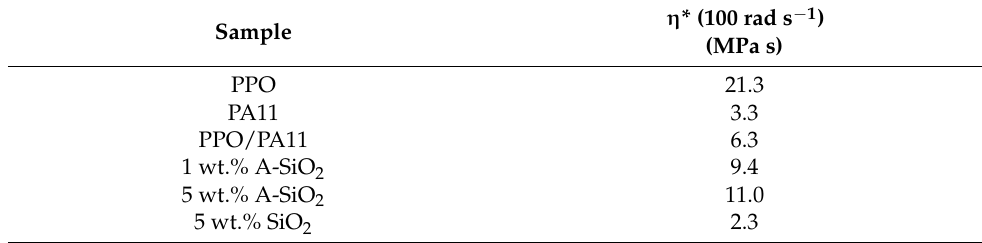
Table 2. Rheological data of PPO, PA11, and PPO/PA11/silica